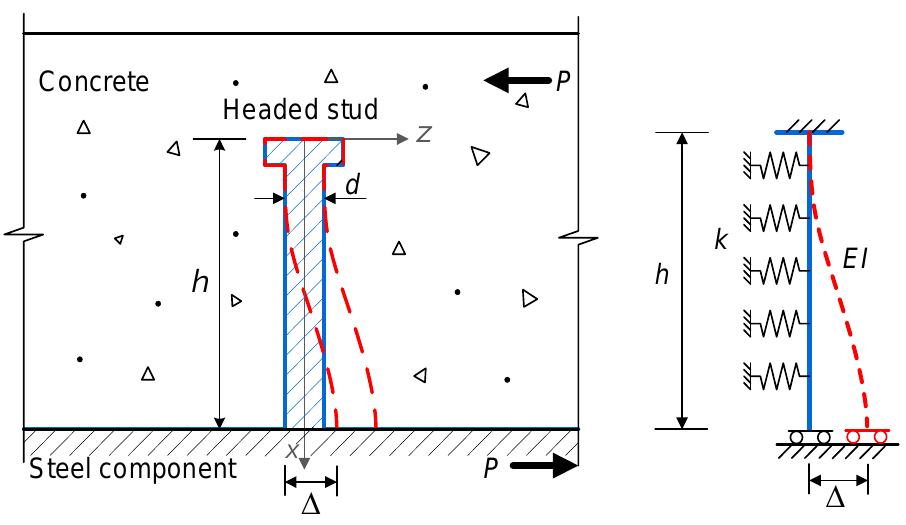
Figure 2. The deformation and its analytical model of the headed stud at stages 1 and 2. If the interfacial slip between the concrete slab and the steel beam is ∆ , the deflection of the headed stud in the z -direction can be expressed by Equation (1), according to the beam on Winkler foundation